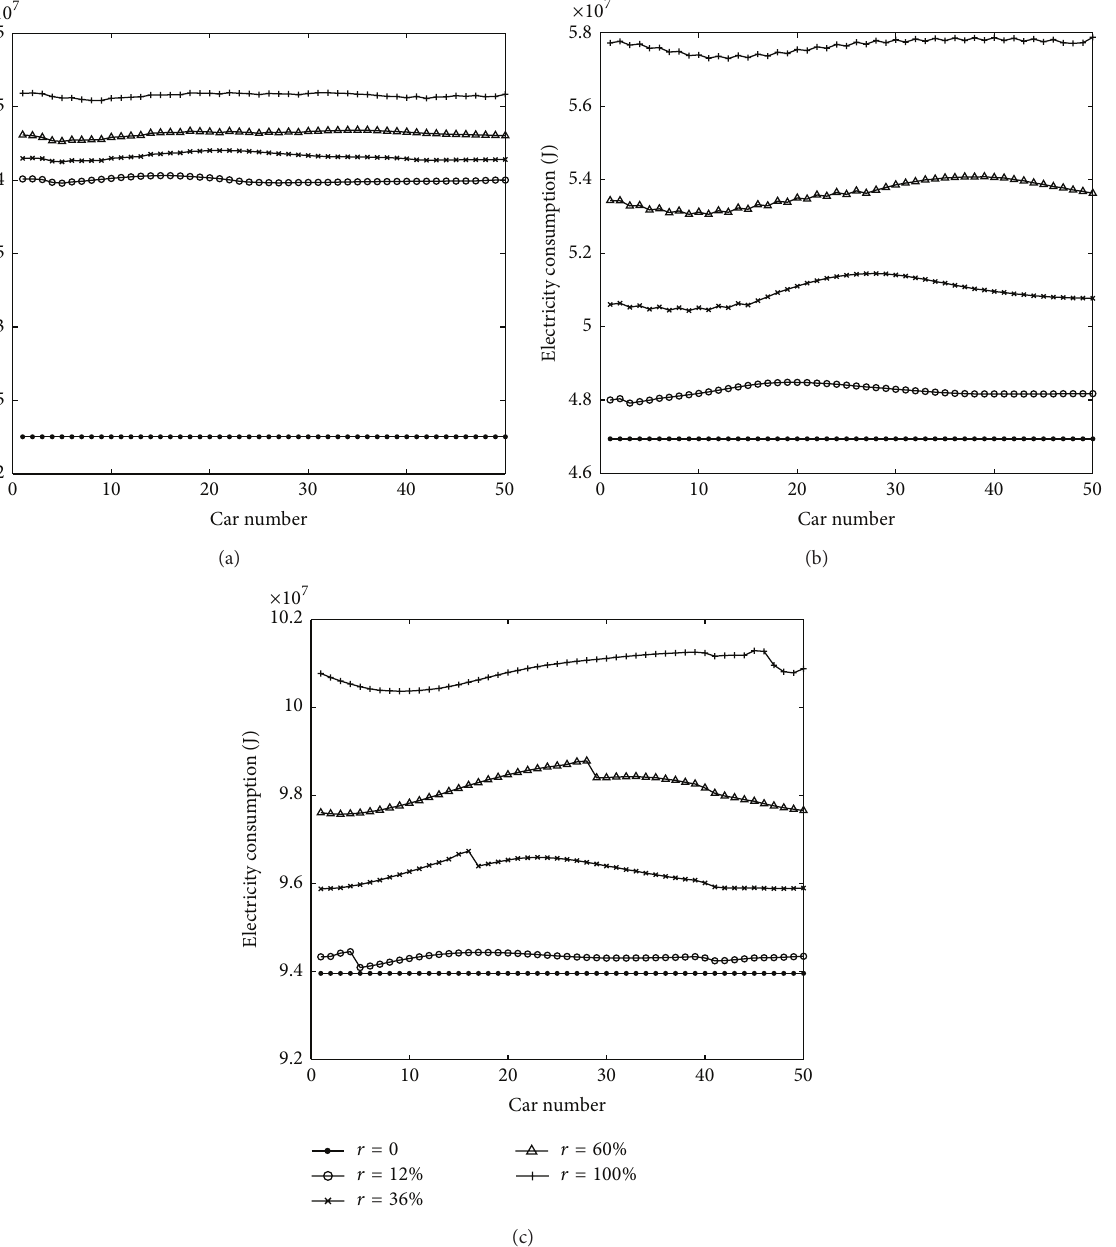
Figure 6: The total electricity consumed by each vehicle when the distance between the two charging stations is 300m, where (a) Δ𝑥 0 = 20 m, (b) Δ𝑥 0 = 40 m, and (c) Δ𝑥 0 = 80